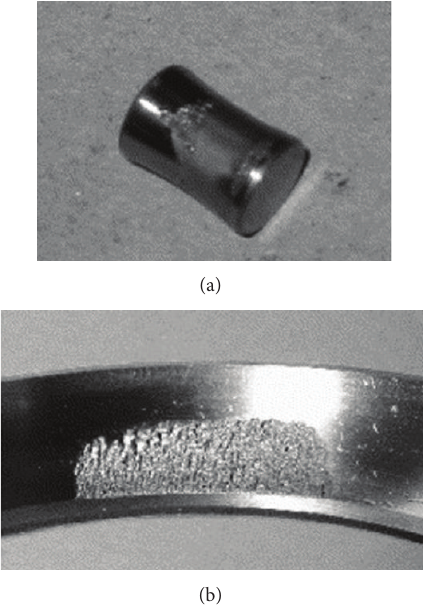
Figure 4: The bearing components with serious wrecked after test with roller element defect and outer race